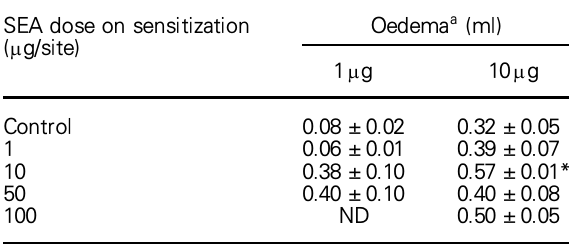
Table 2. Increase of the oedematogenic effect induced by different doses of SEA in challenge of rat paws sensitized